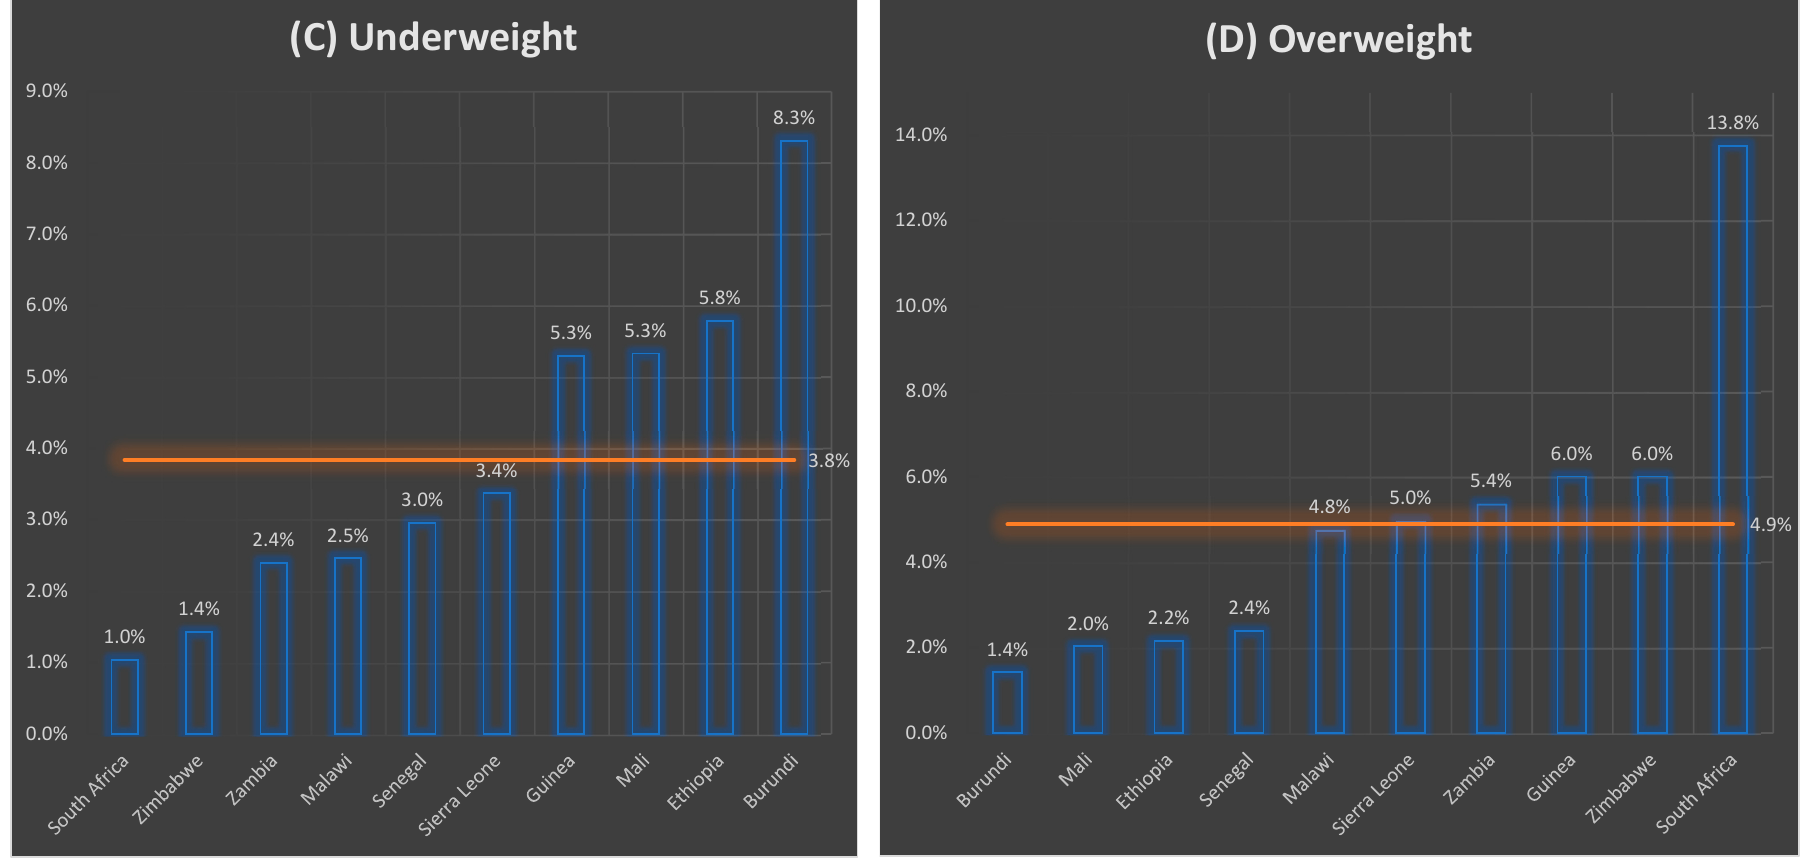
Figure 1. ( A – D ) Prevalence of wasting, stunting, underweight and overweight by country.